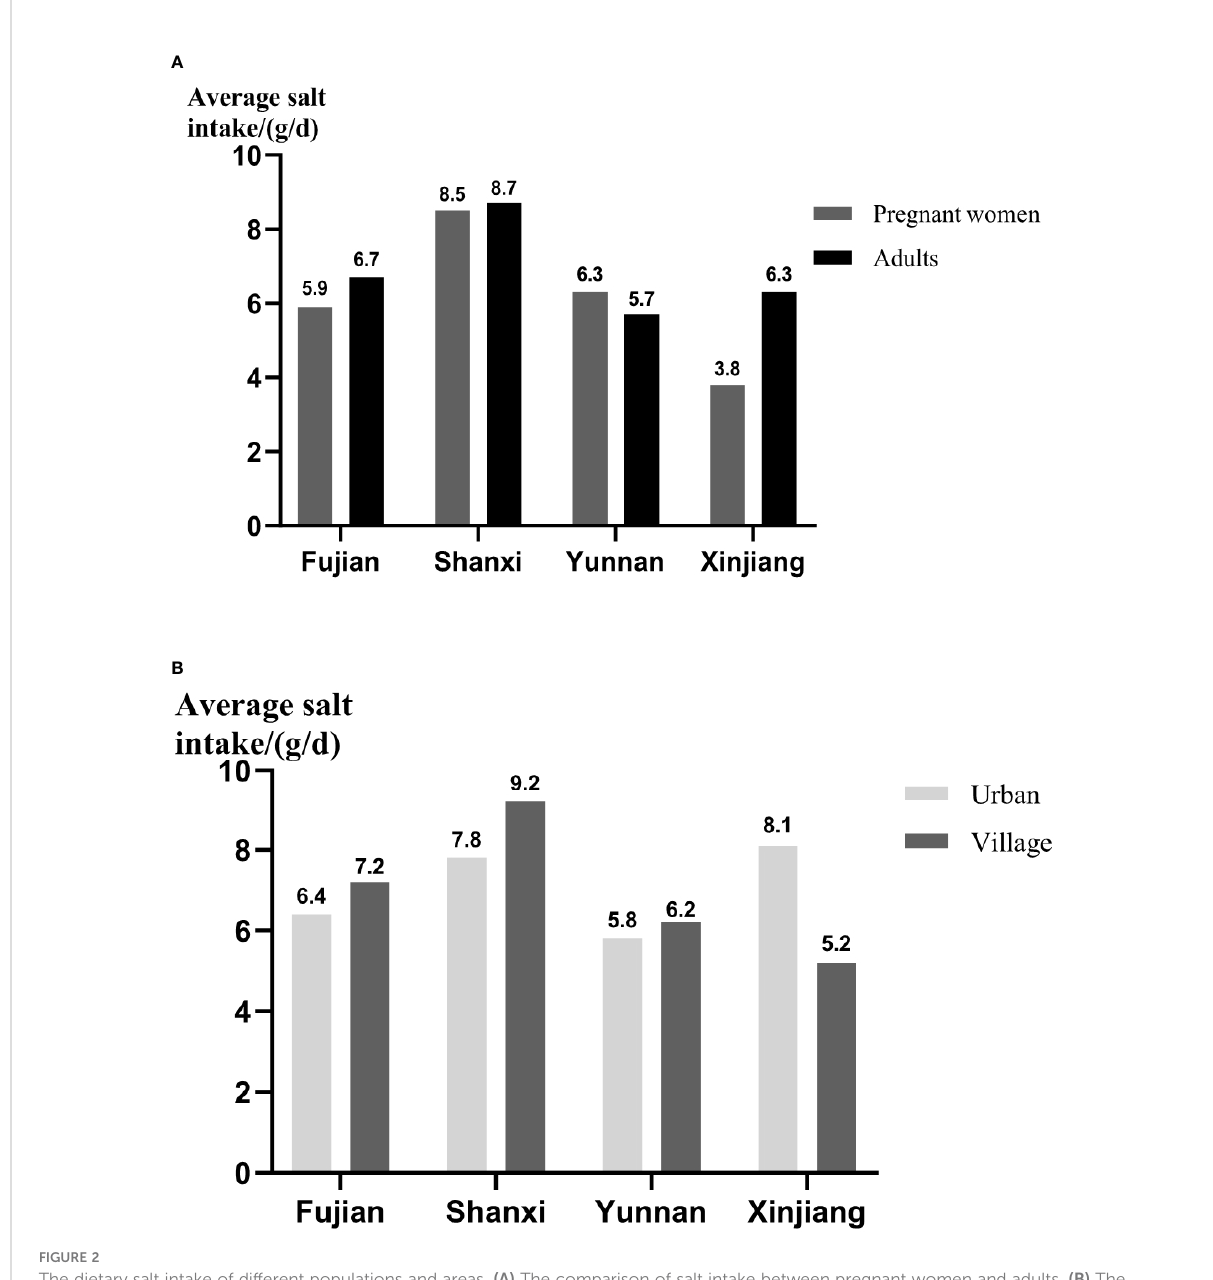
FIGURE 2 The dietary salt intake of different populations and areas. (A) The comparison of salt intake between pregnant women and adults. (B) The comparison of salt intake between adults in urban and village. The daily average intake of salt was presented as means ±